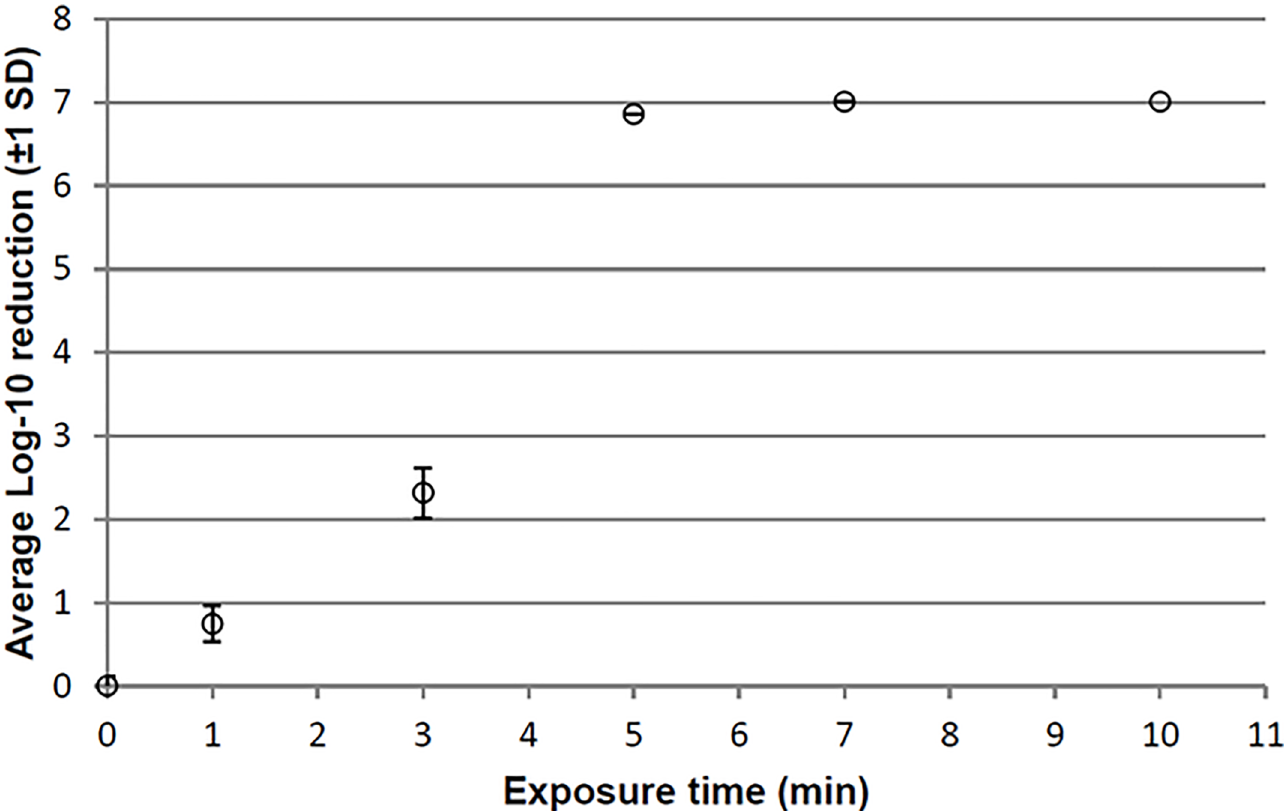
Fig 1. Suspension test: Reductions of C . difficile spores in 1147 ppm peraceticacid (starting concentration) at 20˚C.